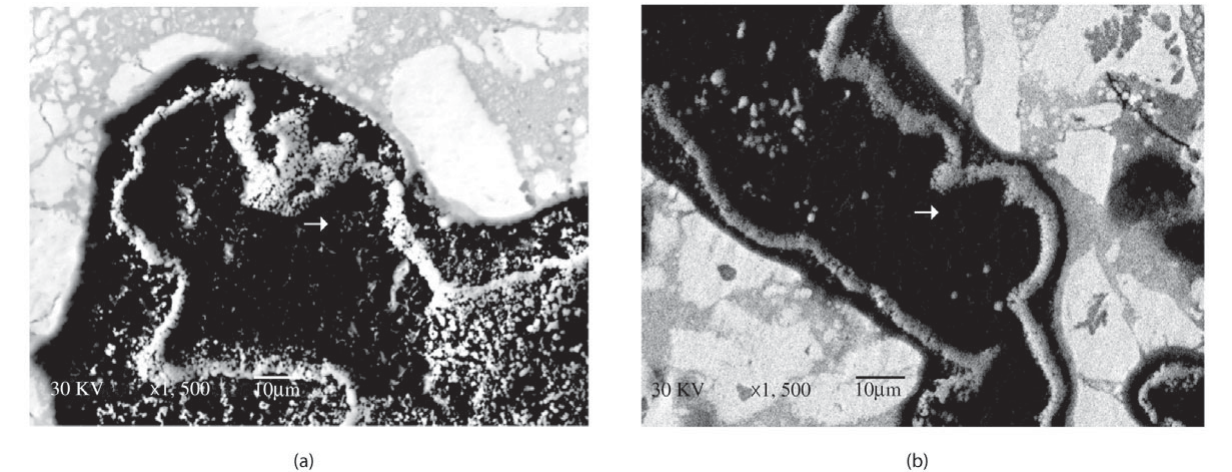
Figure 2. Scanning electron micrographies of Nb rich layer: a) before heating cycle; b) after heating cycle.